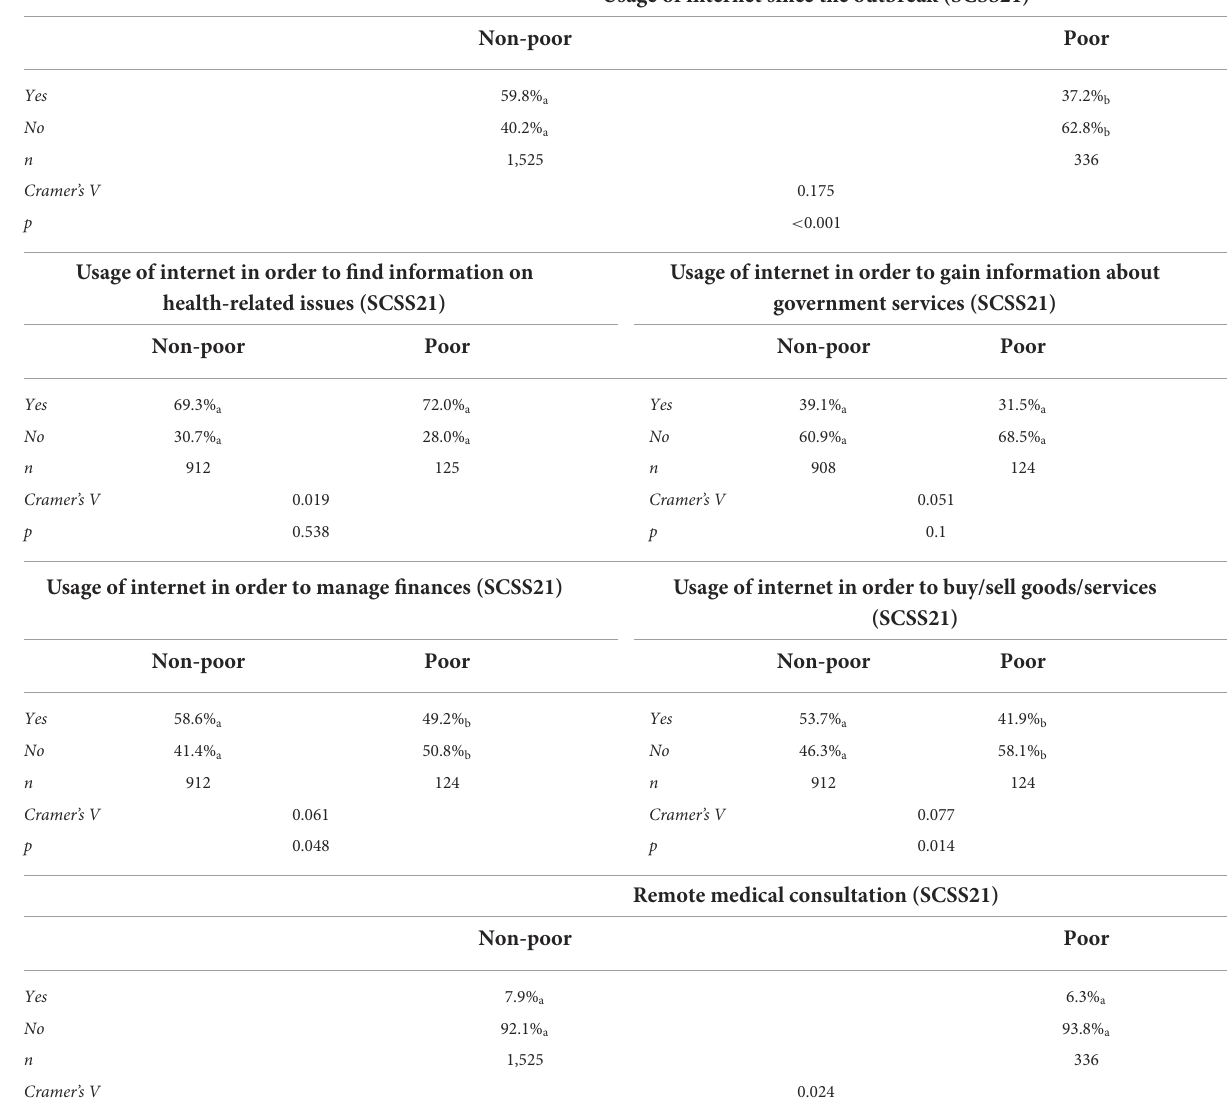
TABLE 7 ICT use.